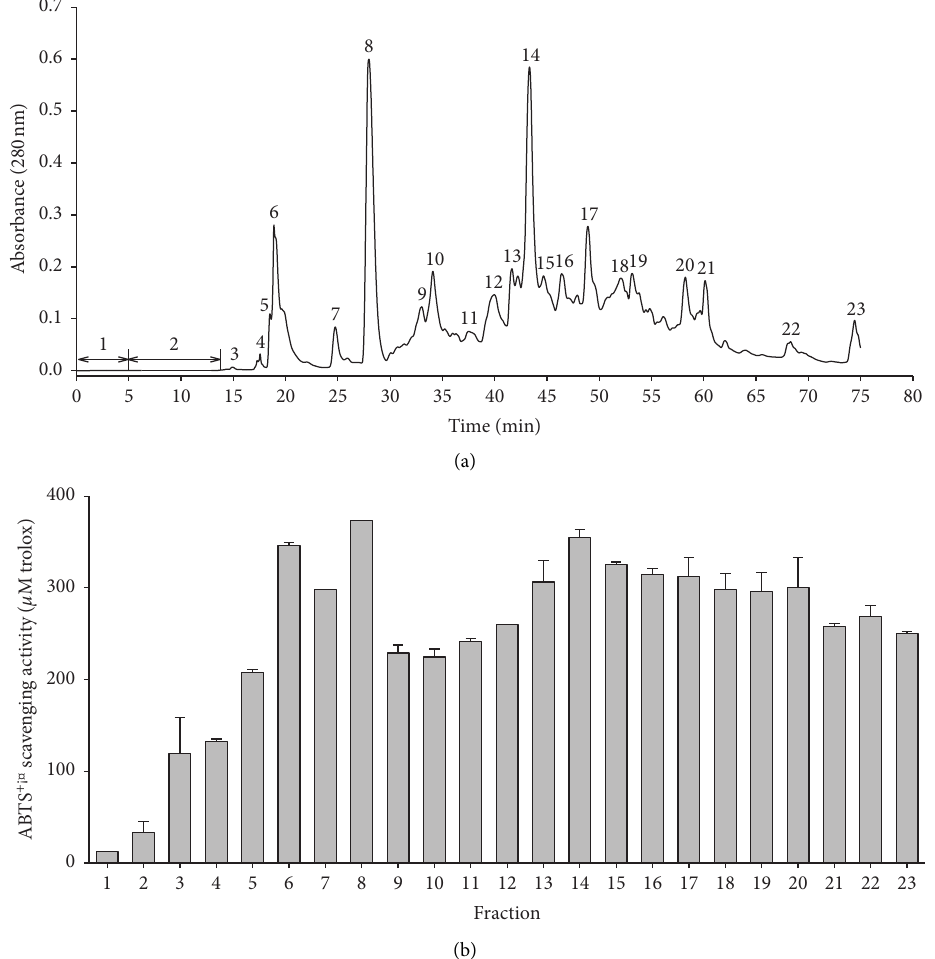
Figure 4: Preparative RP-HPLC spectra of peak 3 obtained from PPH mixture using gel filtration after ultrafiltration with 23 isolated fractions labeled by numbers (a), and ABTS+ • scavenging activity of these individual correspondent fractions at the protein concentration of 50 μ g/mL (b). Table 1: Antioxidant peptides from selected fractions in PPH that were isolated and identified using UPLC-MS/MS. Fraction Peptide MW Prob. (%) Matched sequence in patatin a Ala-Ala-His 297.1 99.99 Not P3F6